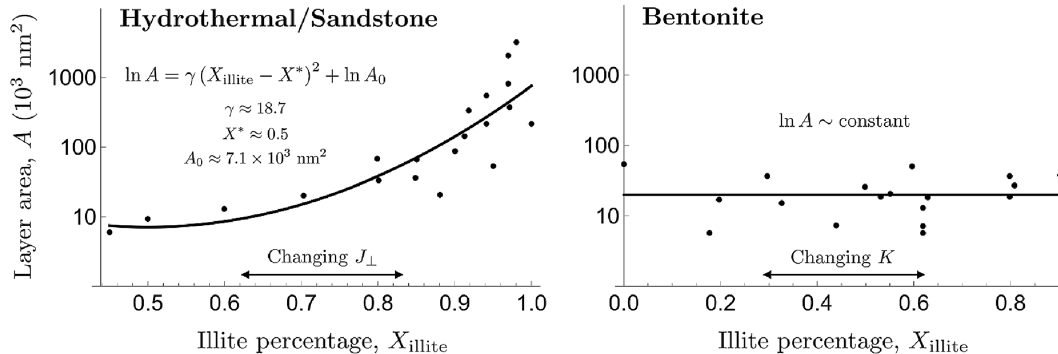
Figure 5. Layer areas in illite-smectite mixed layers from two different geological environments as a function of the percentage of illite. The solid lines are fits based on Eqs. (20) and (21). Data are taken from 4